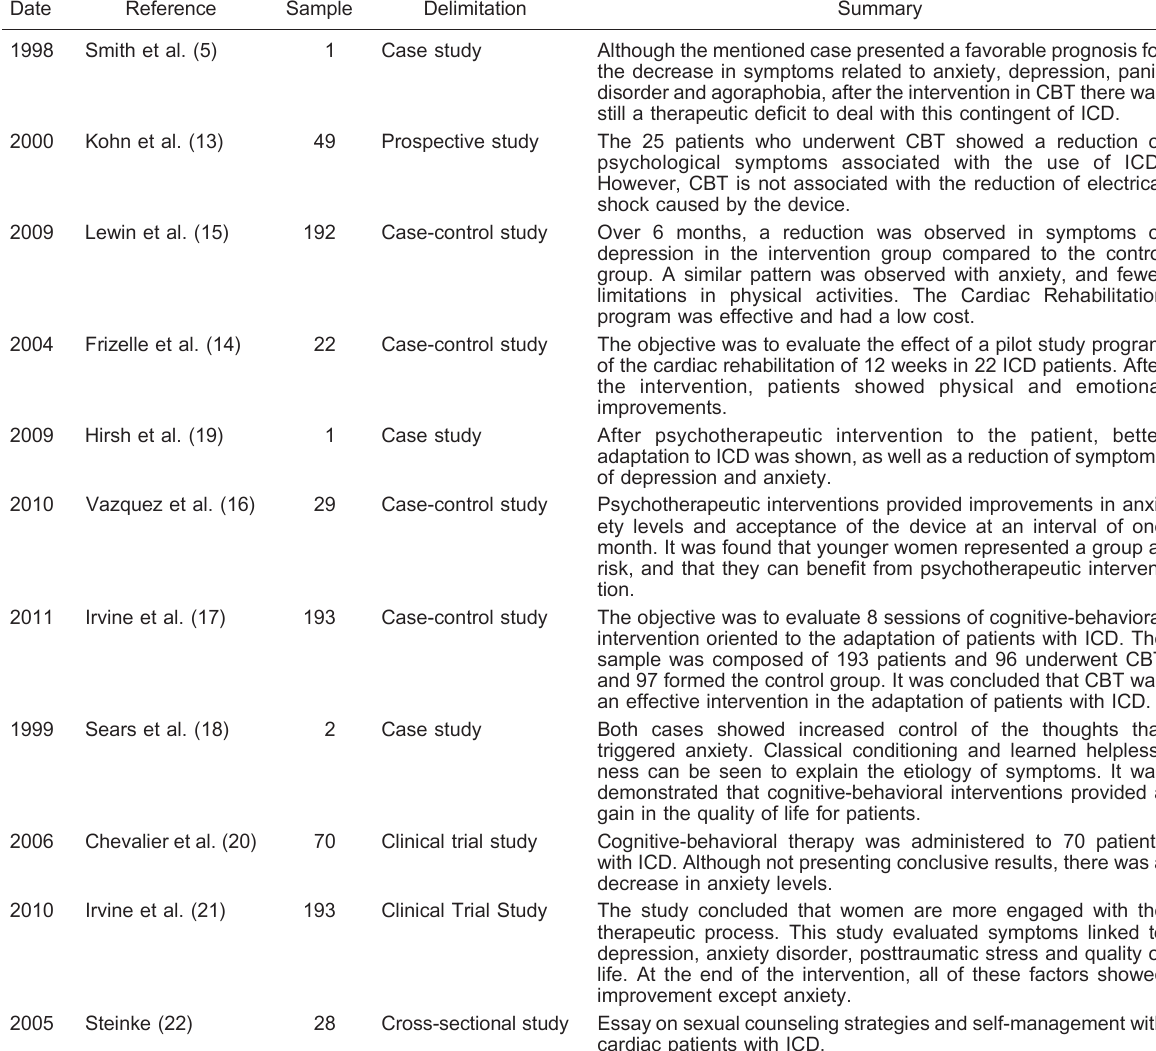
Table 1. Published studies about cognitive-behavioral therapy (CBT) for the reduction of psychiatric symptoms in patients with implanted cardioverter defibrillators